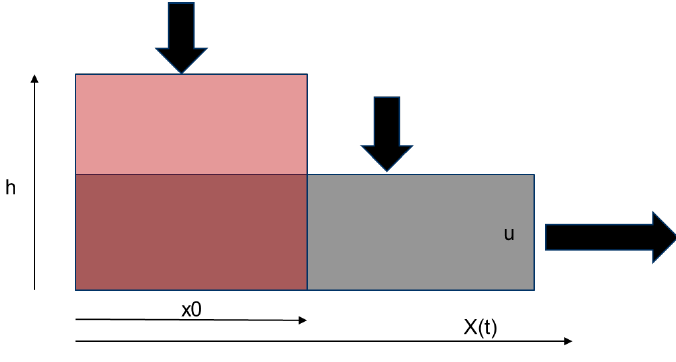
Figure 8. Compression molding setup.